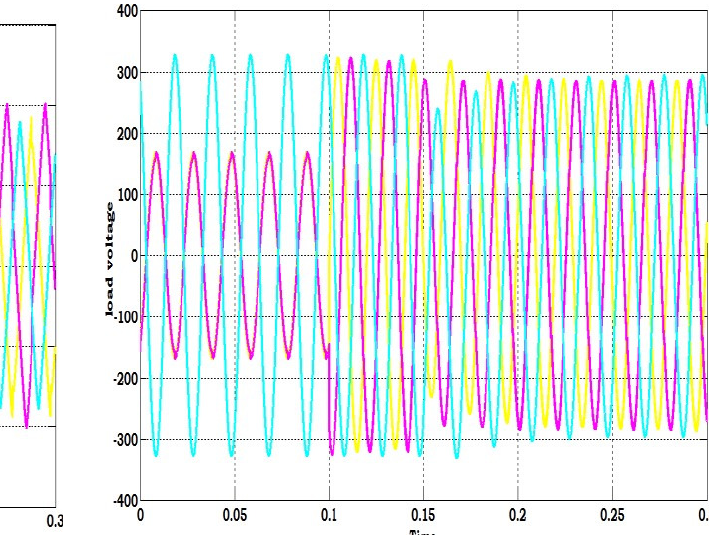
Figure 14. Waveform of Current at PCC